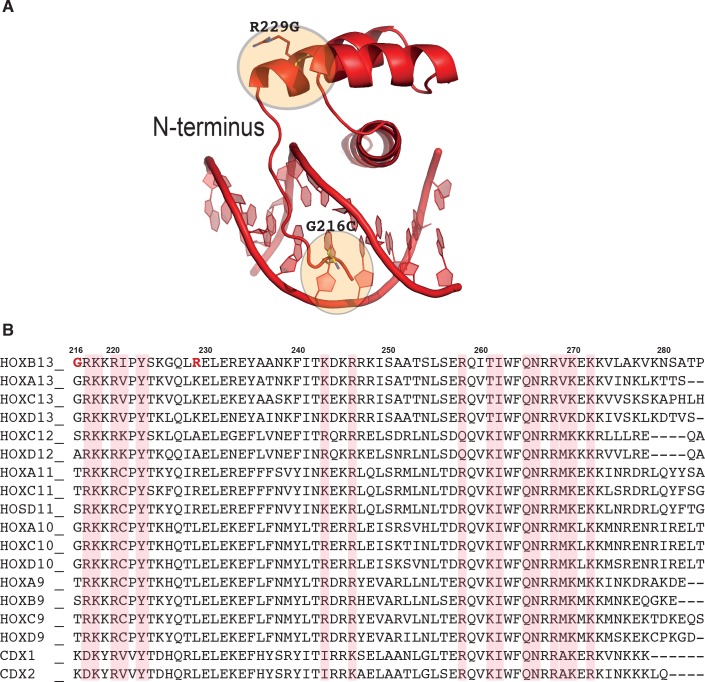
HOXB13 prostate cancer mutation.(A) Structural representation of two of three residues found mutated in single prostate cancer families, Gly-216-Cys and Arg-229-Gly. The mutated residues are presented in ball-and-stick style and highlighted with orange rings. Note that the first mutation Gly-216-Cys belonging to the N-termini of HOXB13 DBD can affect the interactions forming by protein in narrow minor groove. The other mutation Arg-229-Gly is located at the beginning of helix one and because glycine residue is known as ‘helix-breaker’ the mutation can affect the interaction between N-termini with DNA as well as the interaction between two helixes. (B) Sequence alignment of posterior members of HOX family. The cancer mutations found in HOXB13 are colored red. Light red columns highlight the residues involved in interactions with DNA. The numbering corresponds to HOXB13.